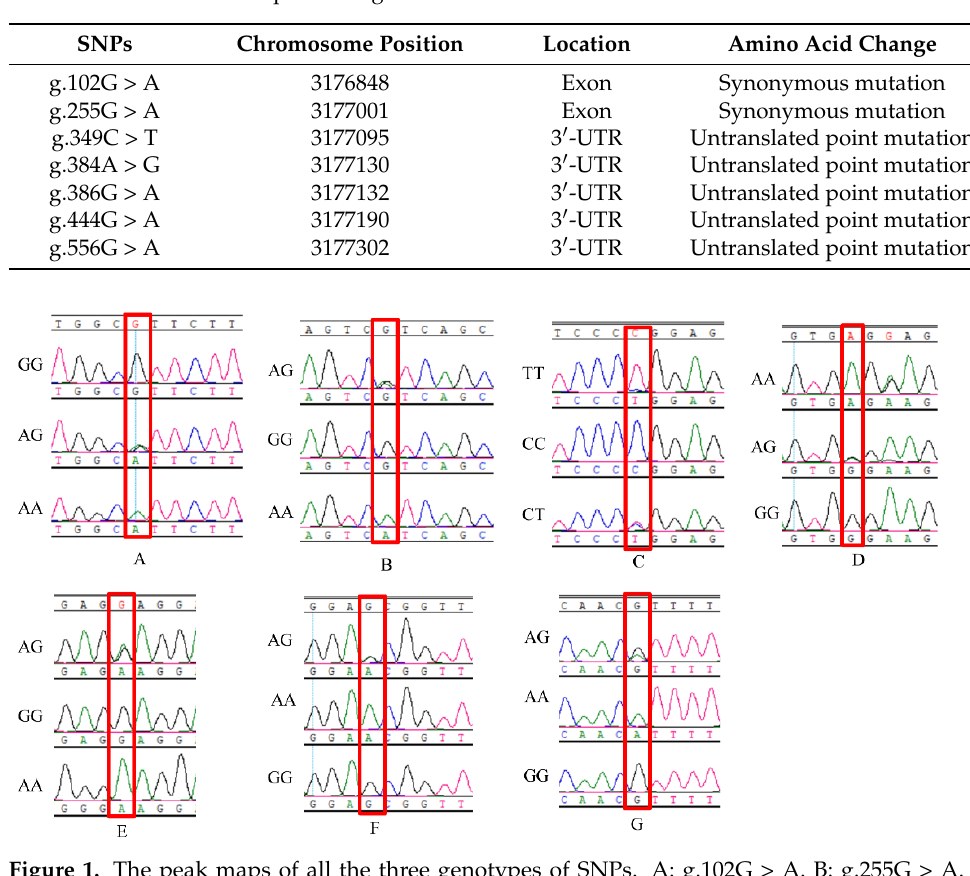
Table 1. SNPs detected on partial fragments of G0S2 .